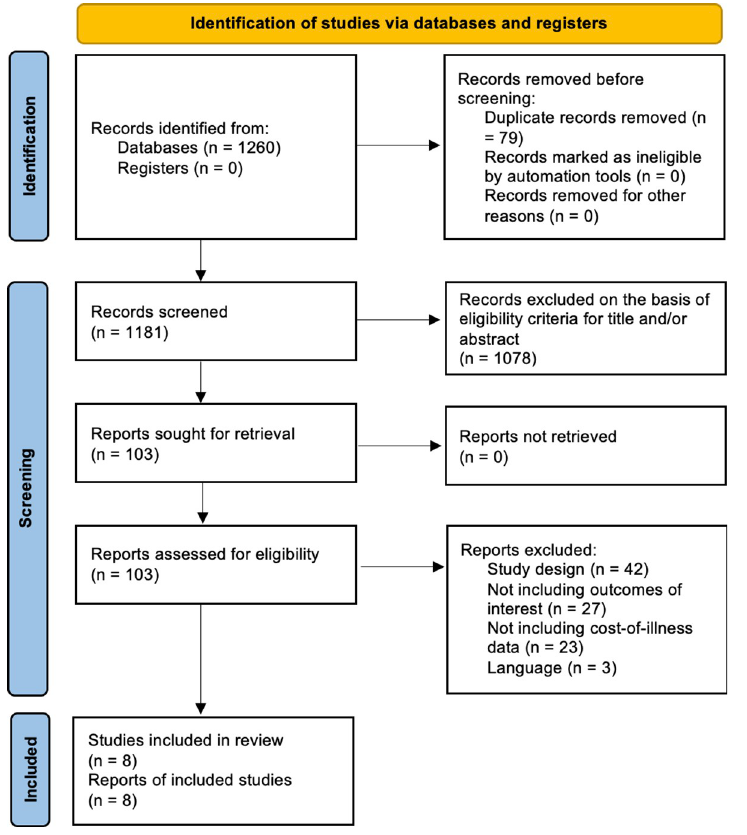
Fig 1. PRISMA 2020 flow chart of the included studies selection